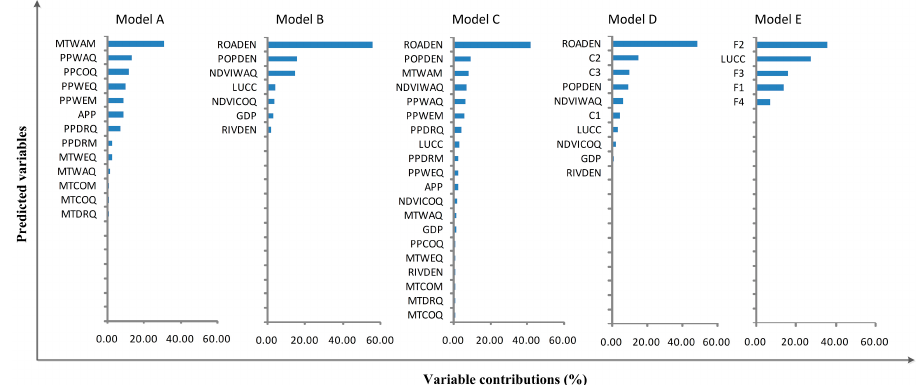
Figure 3. Average contribution of predicted variables over 10 Maxent runs.